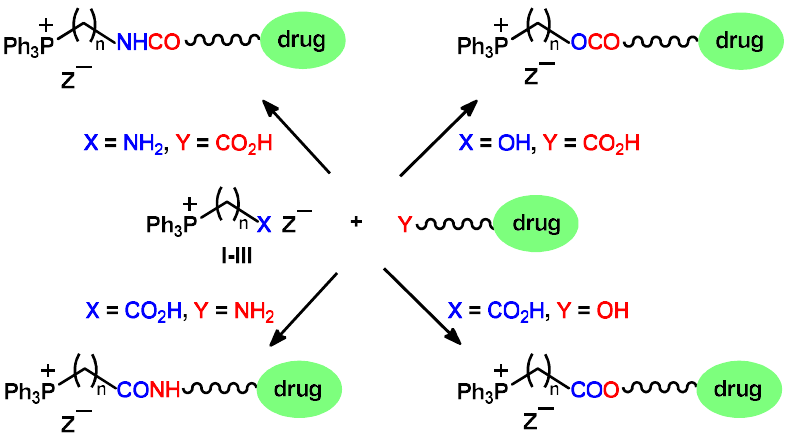
Molecules 2021 , 26 , x FOR PEER REVIEW